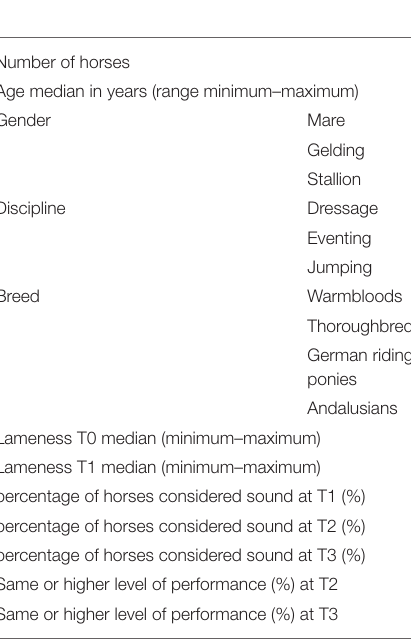
TABLE 1 | Summary of the horses’ signalment and lameness grades at presentation (T0). Number of horses